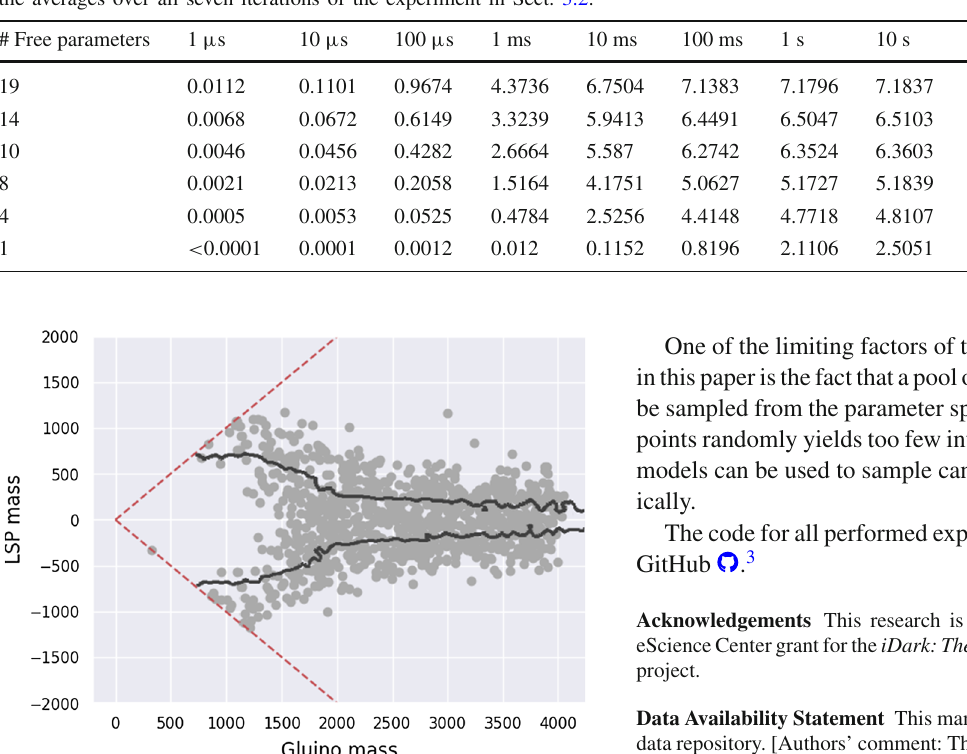
The last column shows the performance gain (Eq. 2), irrespective of the active learning overhead. Noticeable is that even for lower dimensional parameter spaces active learning can be beneficial, namely when the computational cost associated with querying the oracle becomes high